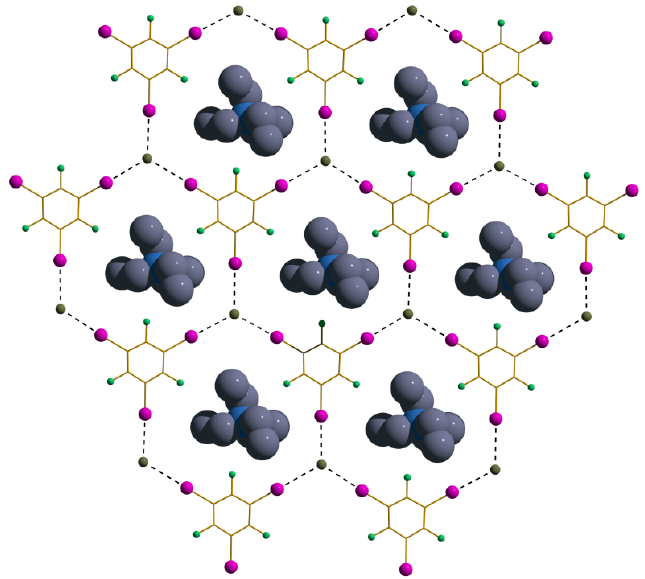
Figure 1. Partial representation of one honeycomb network of 3c . The Et 4 N + cations, sitting at the center of the hexagonal cavities, are represented with space-filling models. The XBs are black dotted lines. Color code: C: grey; N: blue; I: purple; F: light green; Br: olive.